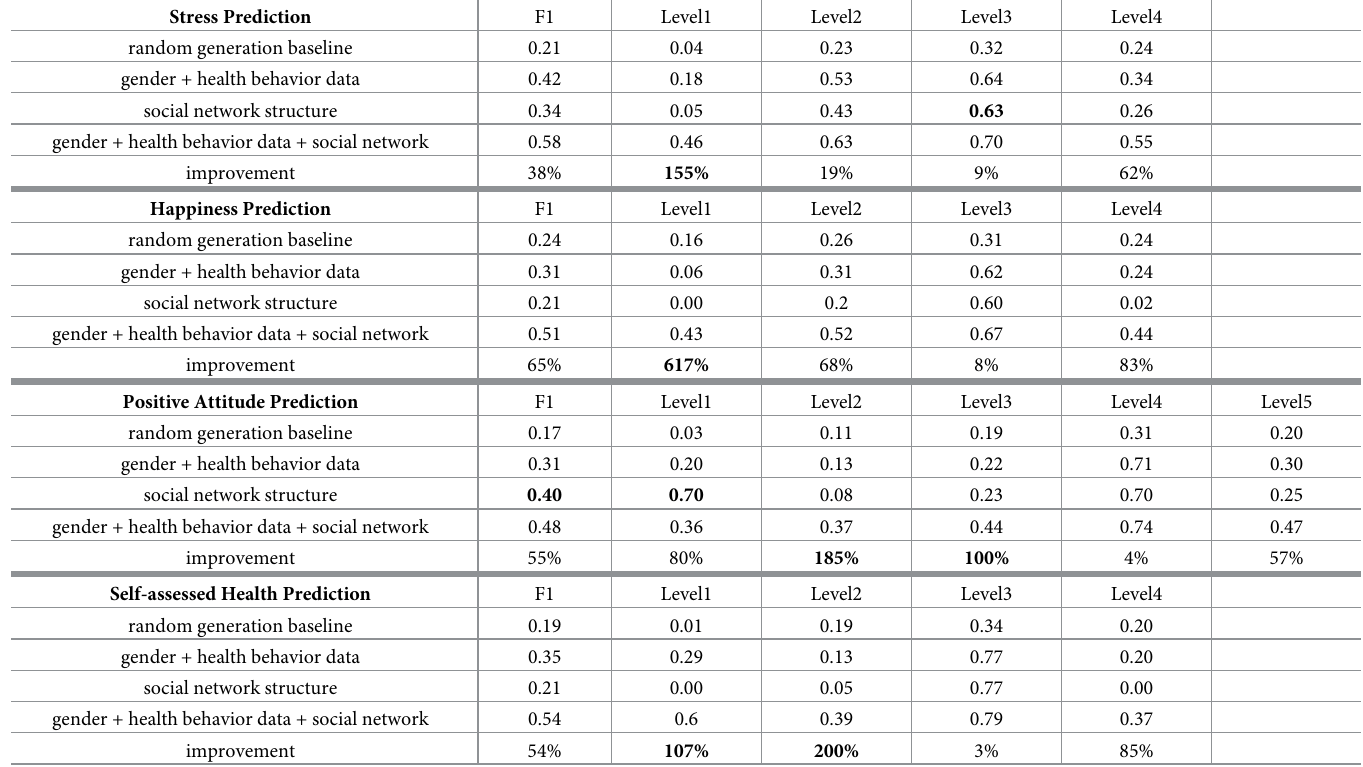
Table 6. Prediction results for happiness, positive attitude and self-assessed